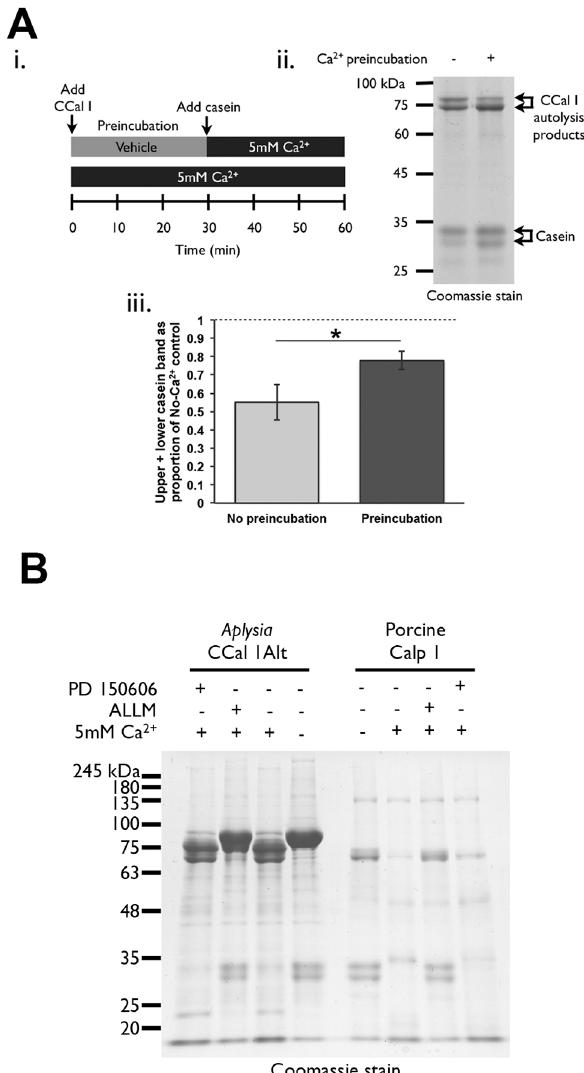
Fig 7. Characterization of the sensitivity of AplCCal1 activity to N-terminal cleavage and calpain inhibitors. (A) AplCCal1(200ng/ul)was pre-incubated for 30min with or without Ca 2+ before additionof casein substrate (205ng/ul)with or without Ca 2+ , then incubated30min before 33ul of the reactionwas subjectedto gel electrophoresis and Coomassie staining.(i) Schematic of experimental design.(ii) Representative Coomassie stained gel. (iii) Quantification of combinedupper and lower casein bands, expressedas a proportionof a control that was never exposedto Ca 2+ . A one-tailedt-test for pairedsamples yieldedp < 0.05,representedby an asterisk ( * ). Data from 3 independentexperiments. Error bars show SEM. (B) After a 20min preincubation with 100uM PD-150606, ALLM or vehicle, AplCCal1alt (325ng/ul)or porcine CAPN-1 (116ng/ul)and casein (195ng/ul)were incubatedin the presenceor absenceof 5mM Ca2+, and in the presenceor absenceof 100uMPD-150606,ALLM or vehicle for one hour at room temperature. Thirty-two microliters of each reaction was subjectedto SDS-PAGE and Coomassie staining.AplCCal1alt was used at higherconcentrations than porcine calp-1 to compensate for its lower activity